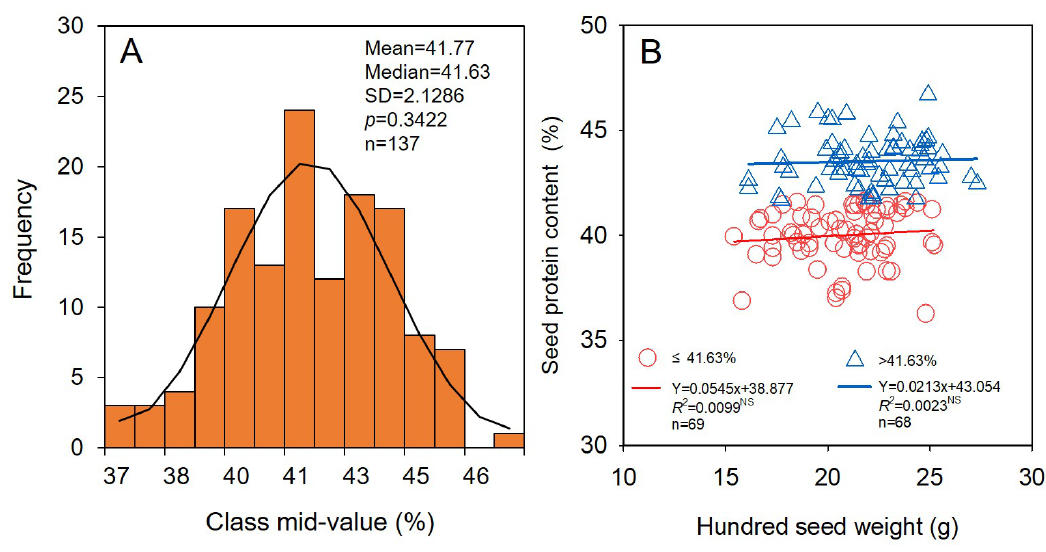
Figure 7. Relationship of seed protein content ( A ) and hundred seed weight ( B ) for soybean. ns indicates not significant different at the 0.05 probability levels. The seed lipids content of soybean in HHH ranged from 17.1% to 23.3%, with mean and median values of 20.14% and 20.30%, respectively (Figure 8A). In addition, under different seed lipids content levels (<20.30% or >20.30%), significant ( p < 0.001 and p < 0.05, respectively) negative relationships were both found between seed lipids content and hundred seed weight of soybean (Figure 8B). Thus, the pursuit of soybean cultivars with large size cultivars would lead to the loss of seed lipids content.